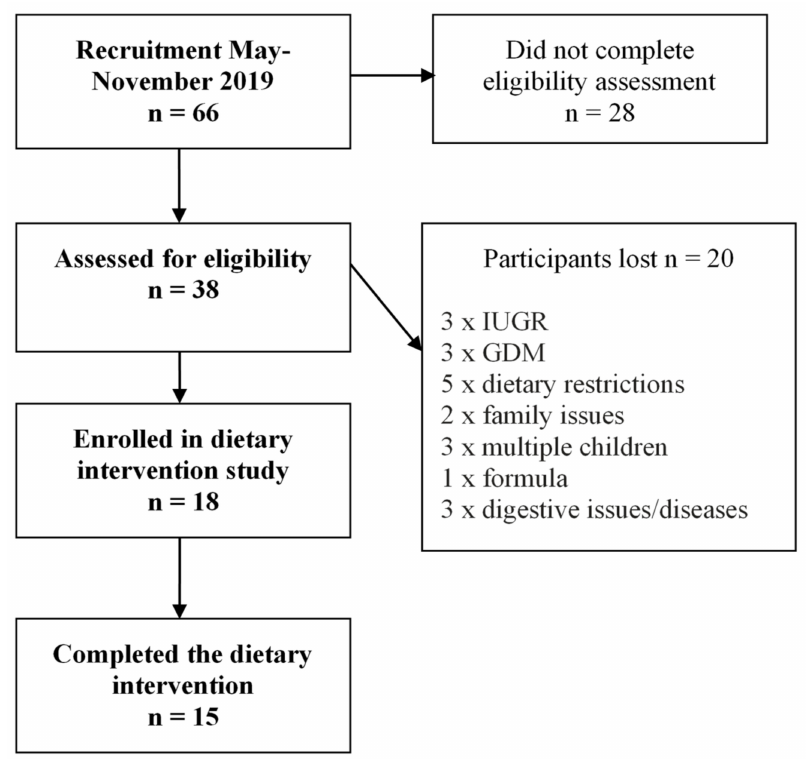
Figure 1. Flow chart of participants from recruitment to completion of study 1 . Three participants did not complete all three weeks of sample collection (two withdrew during week 1 of the study and one only completed the first 2 weeks). 1 GDM, gestational diabetes; IUGR, Intrauterine growth restriction. A total of 796 HM samples were provided and analysed in duplicate for each of the macronutrients. Eleven women provided a complete set of 54 HM samples, and the remaining 4 women provided between 47 and 53 HM samples. Further details on the number of samples analysed for macronutrients can be found in a previous publication [15]. Of the 796 HM samples, 257 were selected for the assessment of metabolic hormones (18 samples per participant with 13 samples